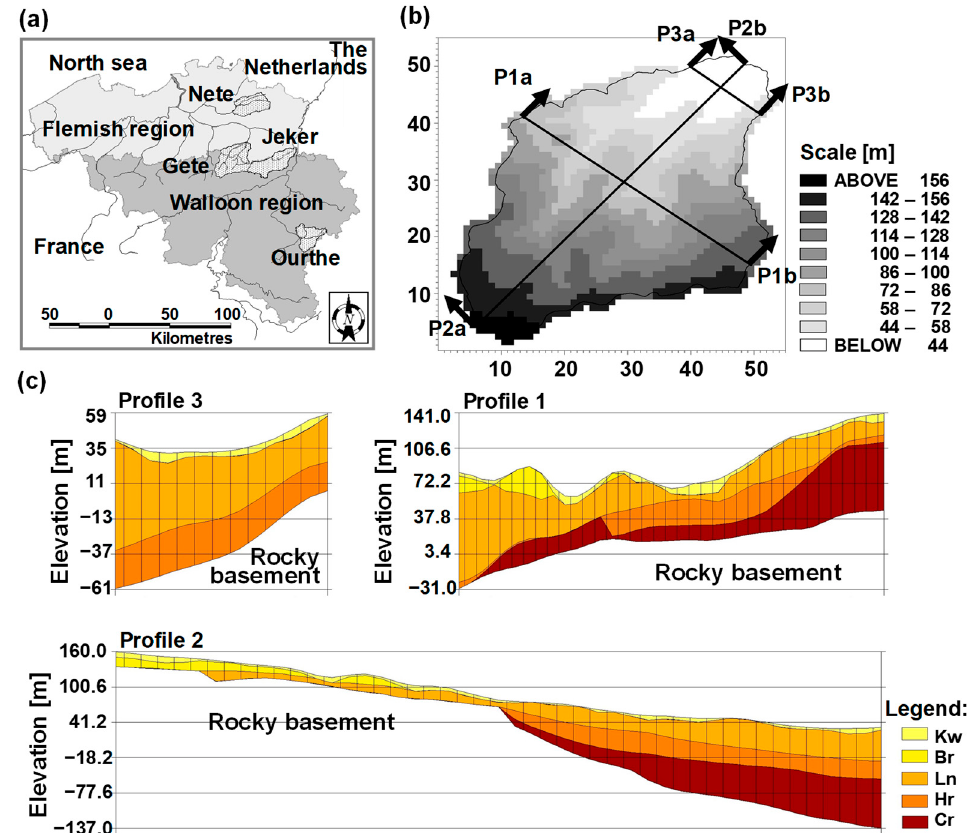
Figure 1. ( a ) Location of the study site, the Gete catchment (after Vázquez, Willems and Feyen [28]); ( b ) digital terrain model (DTM) of the study site and horizontal distribution of ( c ) the vertical profiles of the simplified geological model of the study site (600 × 600 m 2 ) showing the thin loamy Quarternarian deposits (Kw) overlaying the dipping formations, sandy Brusseliaan (Br), clayey sand Landeniaan (Ln), sandy very fine marls Heers (Hr), white chalk Cretaceous (Cr). Below these layers is the Palaeozoic strongly folded rocky basement.